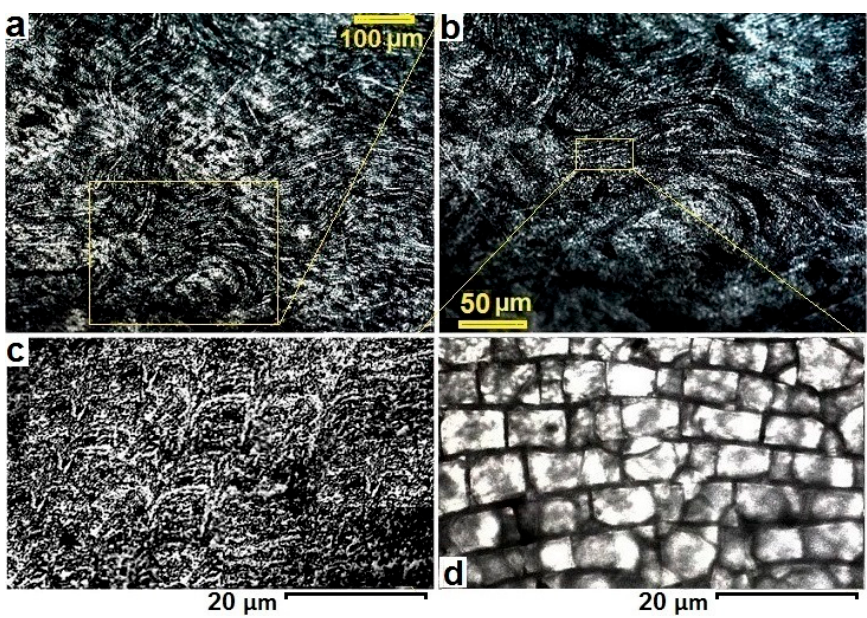
Figure 10. The micro-patterns in the stirring zone for BFSW A6082-T6 at progressive magnification ( a – c ) using etchant H, and ( d ) the mosaic crystallites for the same location of ( c ) processed by etchant I. The yellow rectangles show the progressive area of magnification from ( a ) to ( b ) and then ( c , d ).